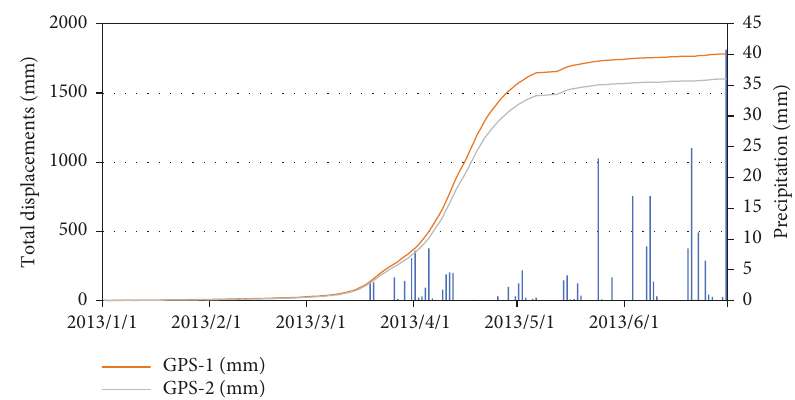
Figure 9: Total displacements measured by GPS versus daily